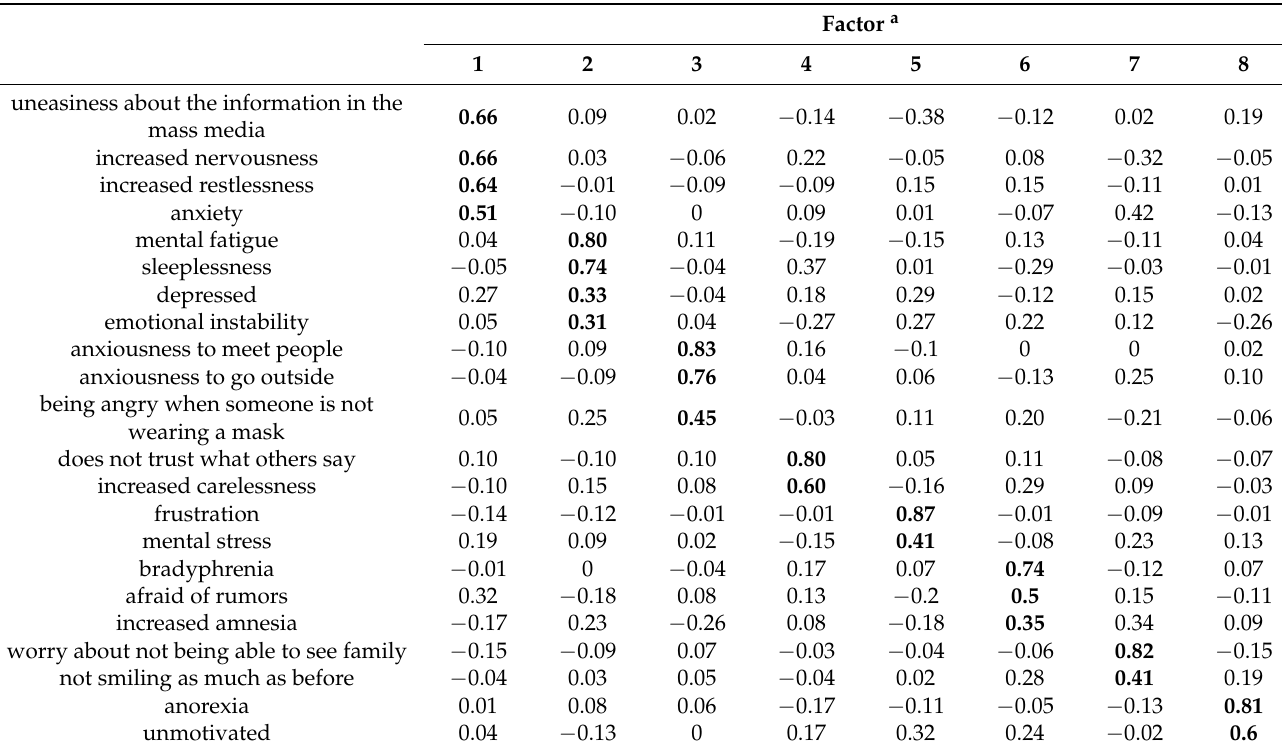
Table 1. Factor Analysis by promax rotation with Kaiser